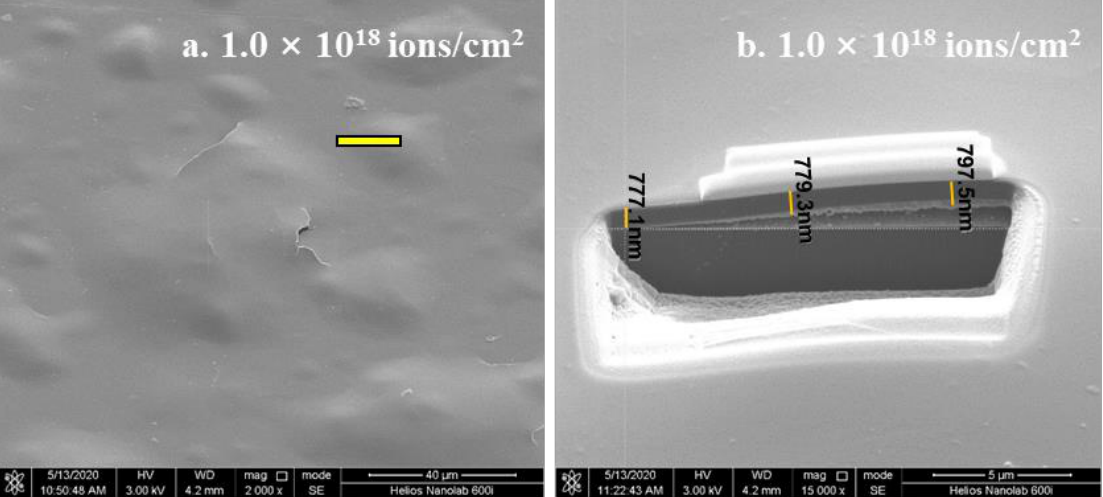
Figure 4. ( a ) the blister of the sample with 1.0 × 10 18 ions/cm 2 . ( b ) Cross-sectional SEM images with a title angle of 52°underneath the FIB cutting is indicated with a yellow rectangle in (a)